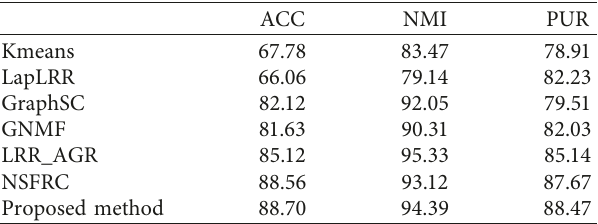
Figure 2: Clustering performances of different algorithms on corrupted ORL dataset. Table 2: Clustering results of different algorithms on Coil 20 Table 5: Clustering results of different algorithms on FERET dataset. dataset.